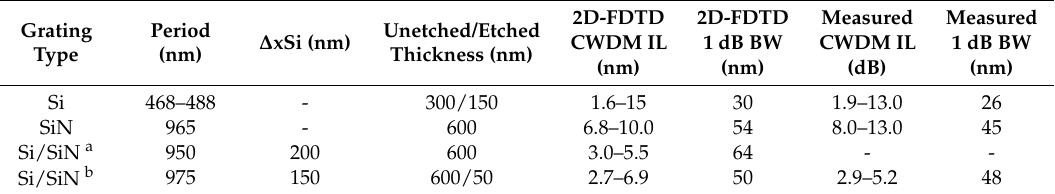
Table 2. Summary of grating parameters and simulated and measured insertion loss (IL) and bandwidth